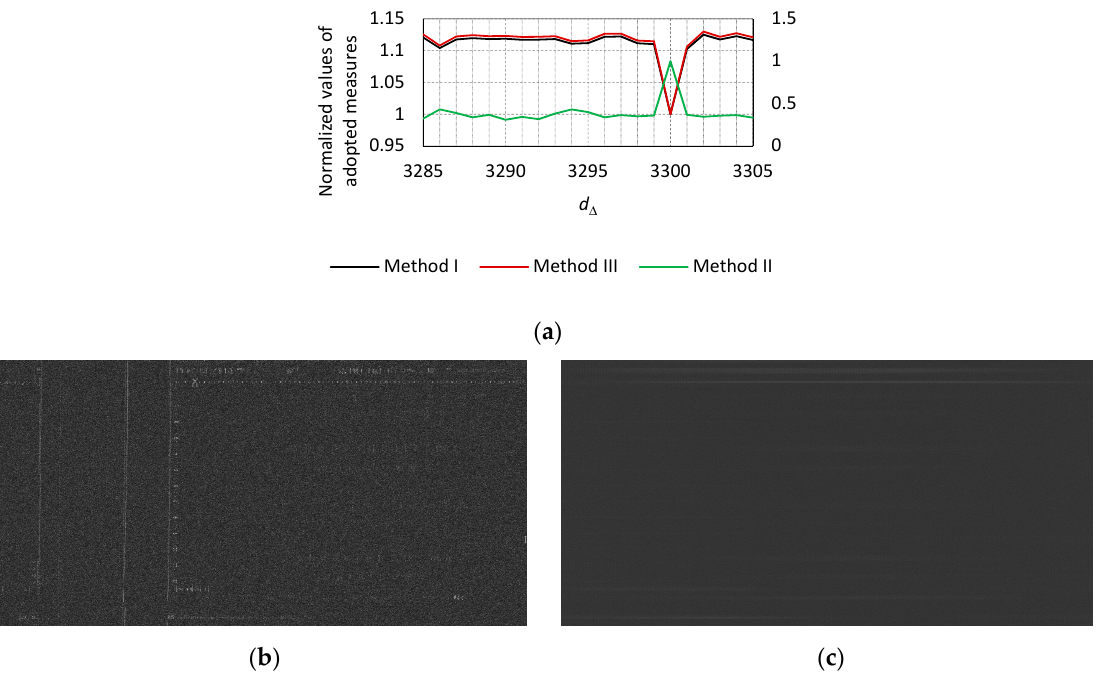
Figure 24. ( a ) The normalized values of the adopted measures (method I, II and III) calculated in domain of image line length d ∆ for the accuracy ∆ = 1.0 (for the original image shown in Figure 7d) and images reconstructed on the basis of the recorded revealing emission signals at frequency f o = 740 MHz (receiving bandwidth BW = 50 MHz, accuracy ∆ = 1.0), ( b ) for estimated line length d ∆ = 3300.00000, image summation multiple Sum MTL = 1 and ( c ) for estimated line length d ∆ = 3300.00000, multiple of image summation Sum MTL = 60 —the source of revealing signal emission—display monitor, VGA